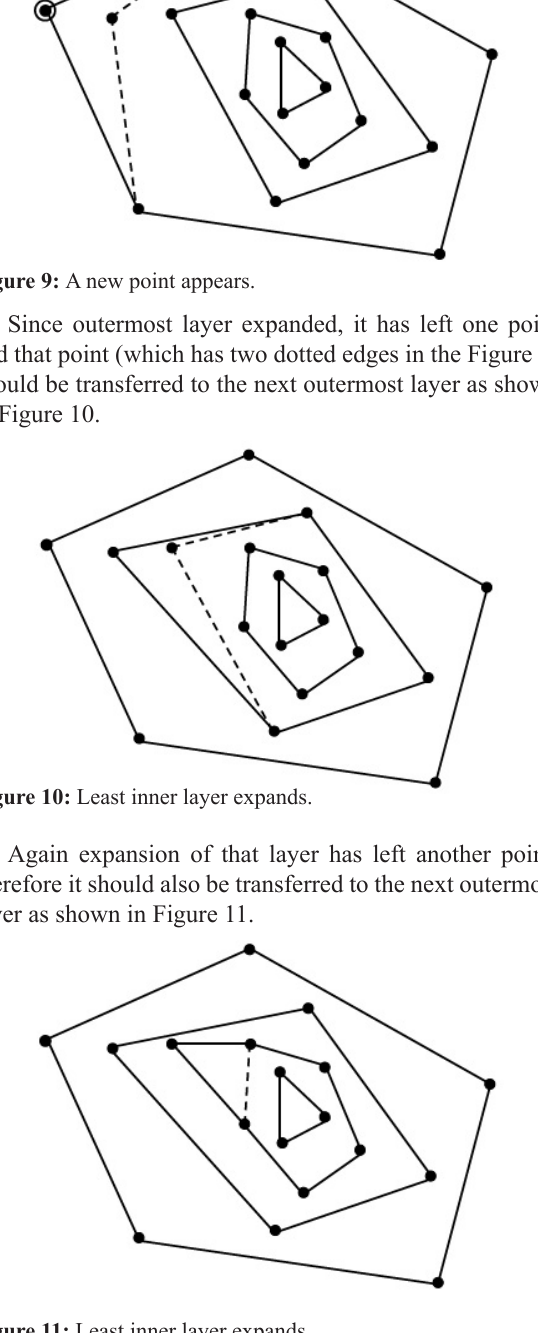
Figure 11: Least inner layer